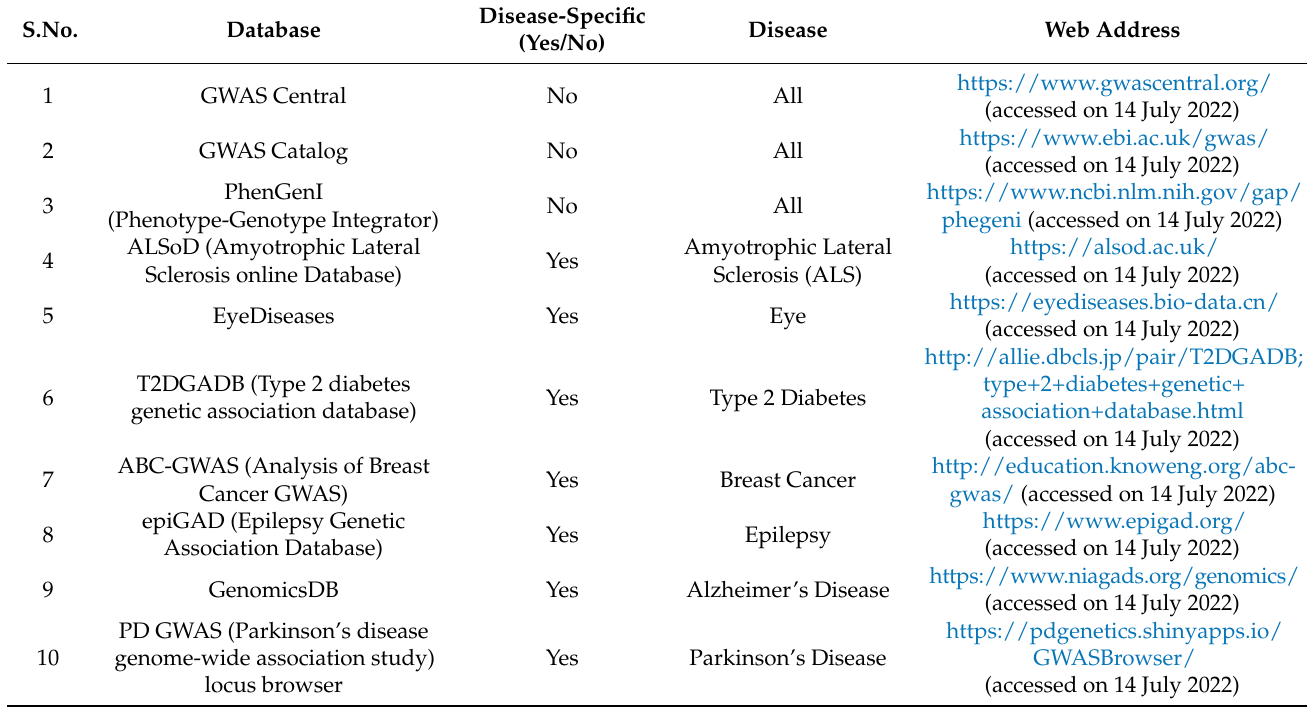
Table 1. Databases that give an overview of Genome-Wide Association Study (GWAS) data. These databases may or may not be specific to a disease. If the database is specific to a disease, then the disease on which this database focused is mentioned in the “Disease” column. A link to this database is also mentioned in the